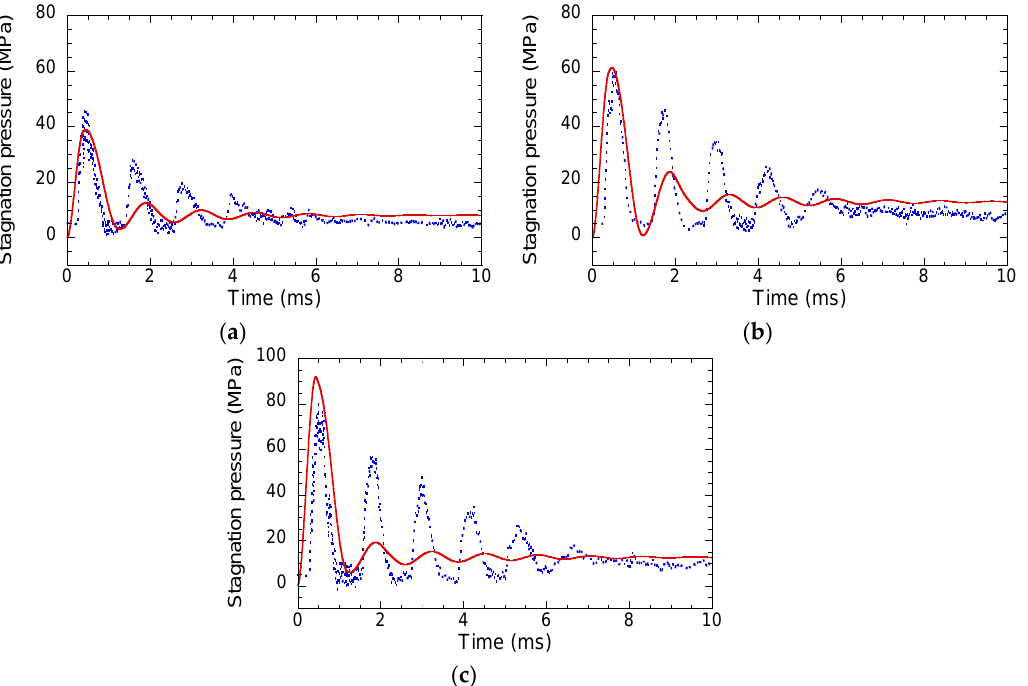
Figure 6. Stagnation pressure evolution from the analytical model with combustible initial pressures of ( a ) 30 kPa; ( b ) 40 kPa and ( c ) 50 kPa.